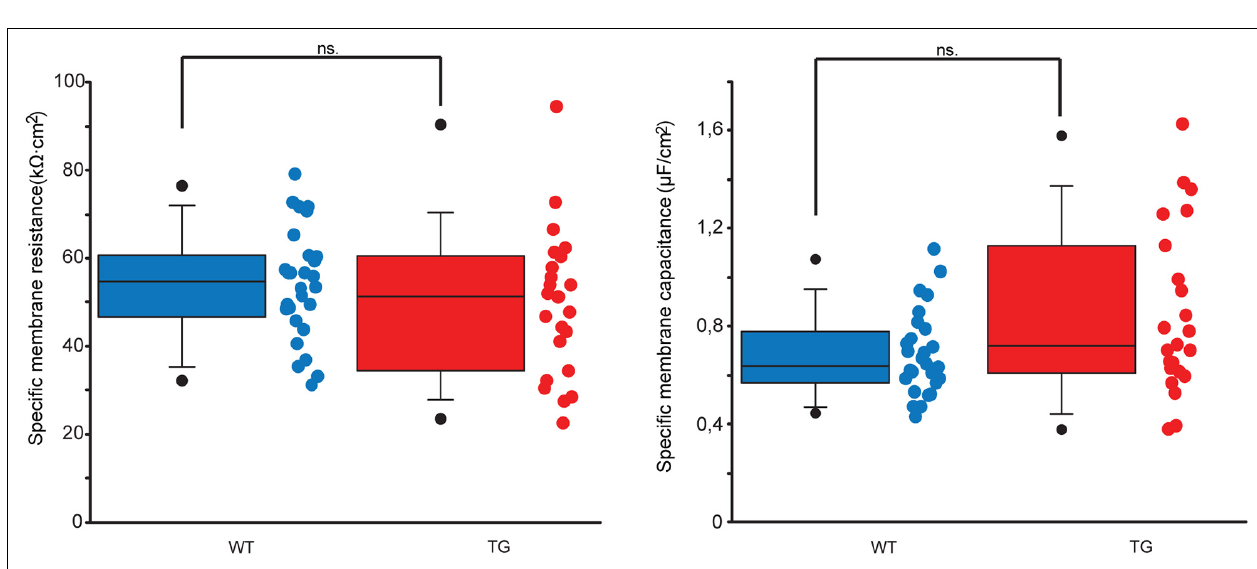
FIGURE 3 | Distributions of dendritic length (solid lines) and surface area (dotted lines) as a function of path distance measured from the soma. Distributions are statistically identical (Kolmogorov–Smirnov test, p > 0.999 both in apical (upper panels) and basal (lower panels) dendritic arbors of WT (left panels) and TG (right panels) neurons.